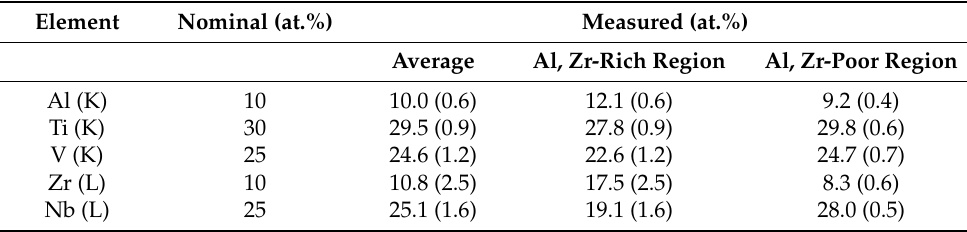
Table 2. Element concentrations of the hydride’s microstructure Al 0.10 Ti 0.30 V 0.25 Zr 0.10 Nb 0.25 H 1.6 , as determined by